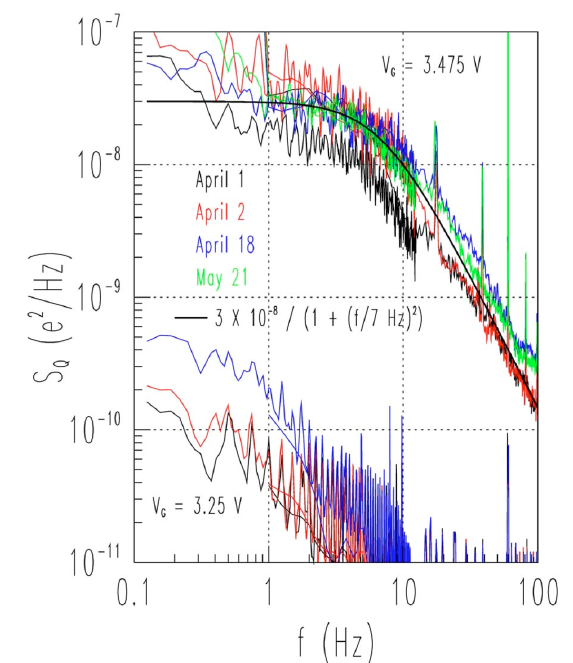
Figure 9. Power spectral density of an Si/SiO 2 device measured at two different gate voltages and over the course of two months including several thermal cycles. The upper cluster of curves at V G = 3.475 V, indicates that a single two-level system (TLS) dominates at this gate voltage. Orders of magnitude less noise is obtained at V G = 3.25 V. The black curve is a fit to a Lorentzian. Reproduced with permission from reference [30], Copyright 2008, American Institute of